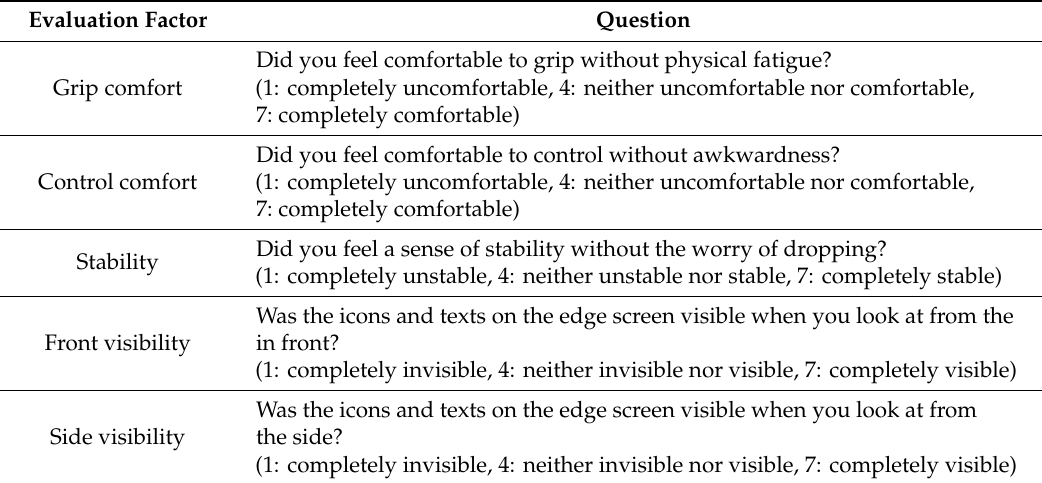
Table 2. Evaluated subjective feelings and their description.